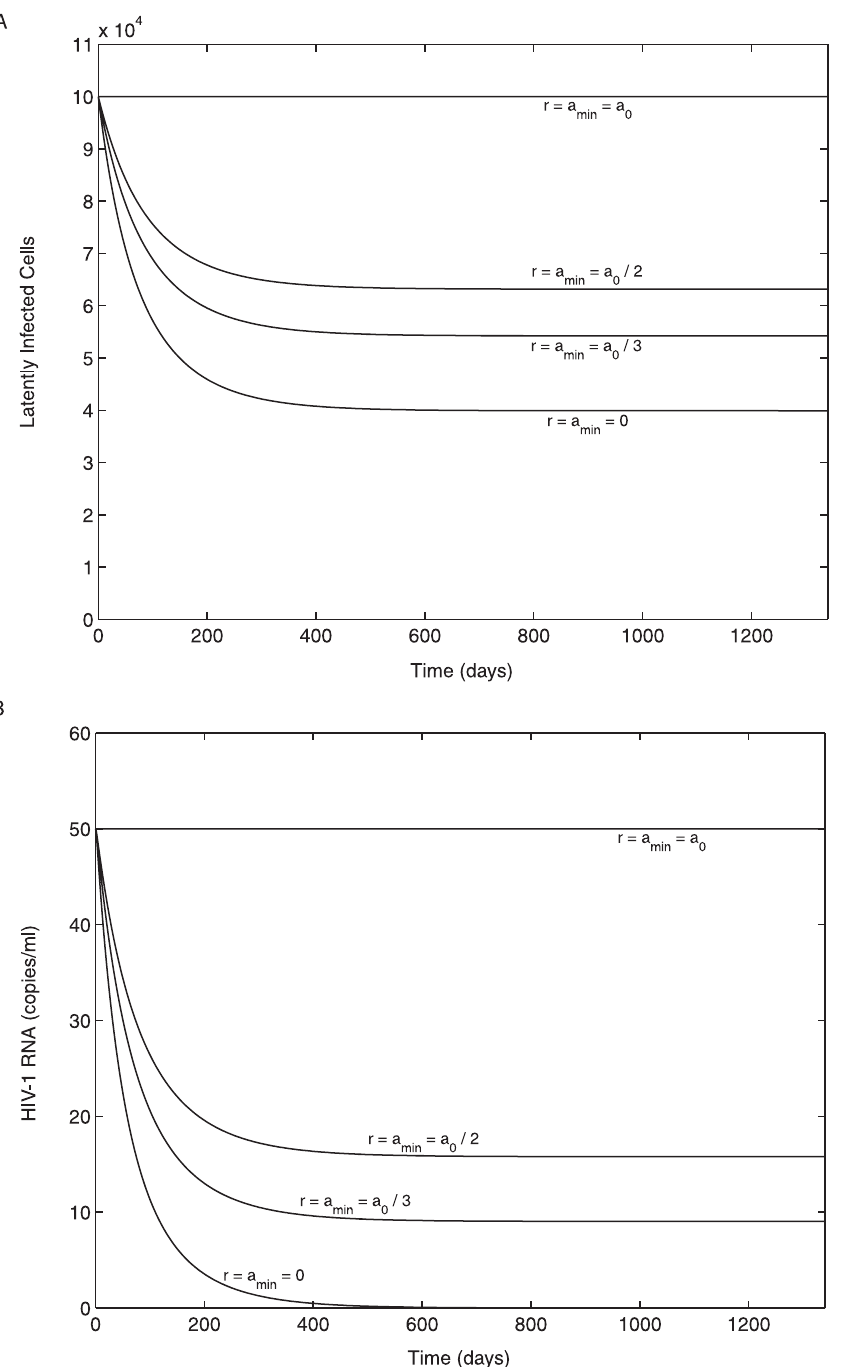
Figure 3. Effect of Persistent Low-Level Activation of the Latent Reservoir on the Latent Reservoir and on Plasma Viral Load When there is no ongoing viral replication ( e ¼ 1) and the rate of bystander proliferation of the latent reservoir is equal to the minimum activation rate ( r ¼ a min ), i.e., at the bifurcation condition. (A) Latent reservoir. (B) Plasma viral load. DOI: